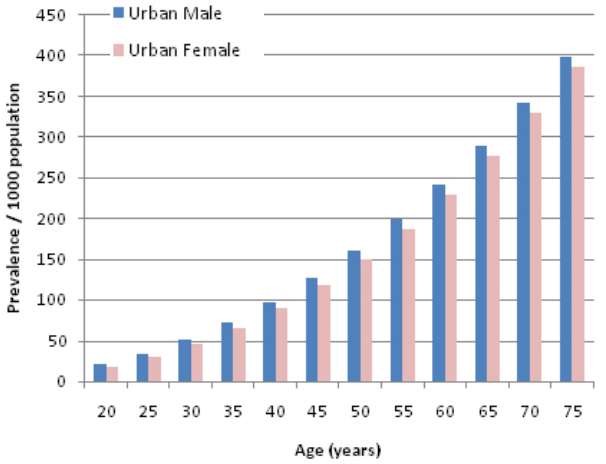
Figure 13. Male and female prevalence of type 2 diabetes in Southern Asia based on information from urban regions.